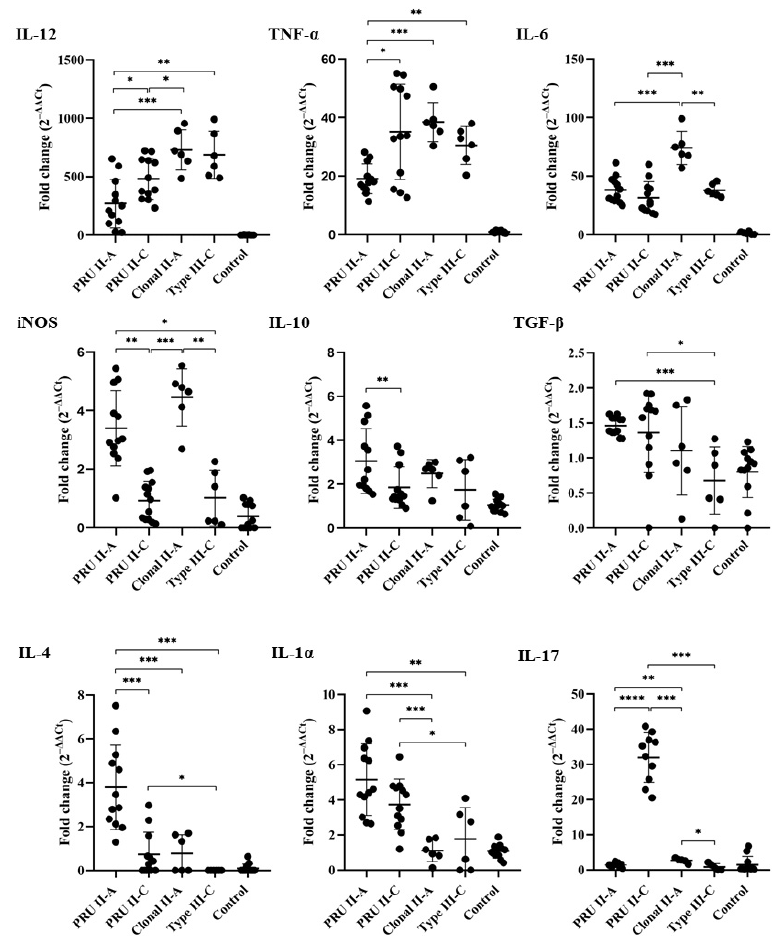
Figure 3. IL-12, TNF- α , IL-6, iNOS, IL-10, TGF- β , IL-4, IL-1 α , and IL-17 transcript expression. Scatter plot graphs of relative mRNA expression levels (as a fold change) of cytokines and iNOS in OvMØs infected with different grouped Toxoplasma gondii isolates (MOI 3:1) at 6 hpi. PRU II-A: type II PRU– abortion origin (TgShSp1 and TgShSp3); PRU II-C: type II PRU–myocardium origin (TgShSp11 and TgShSp16); Clonal II-A: clonal type II–abortion origin (TgShSp2); Type III-C: type III–myocardium origin (TgShSp24). Data represent the mean and standard deviation. Asterisks over the bars indicate significant differences: * p < 0.05; ** p < 0.01; *** p < 0.001; **** p < 0.0001.